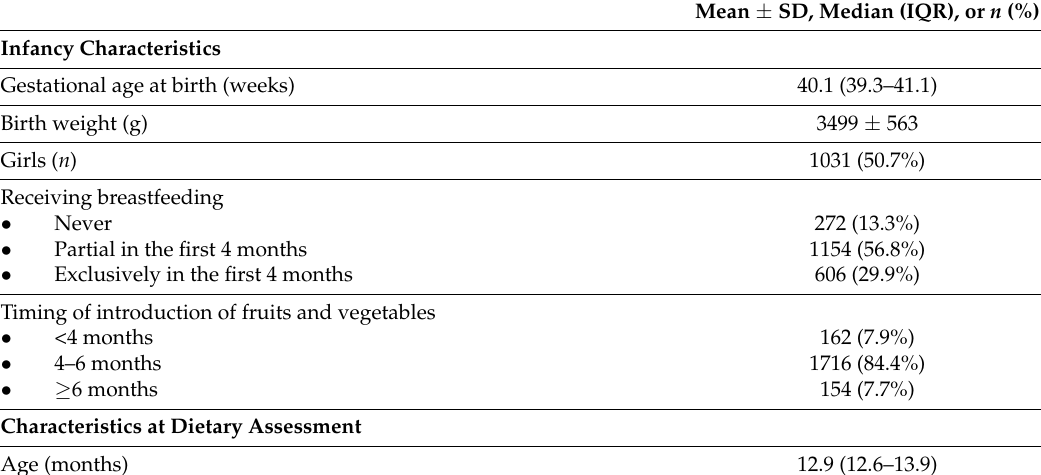
Table 1. Population characteristics ( n =